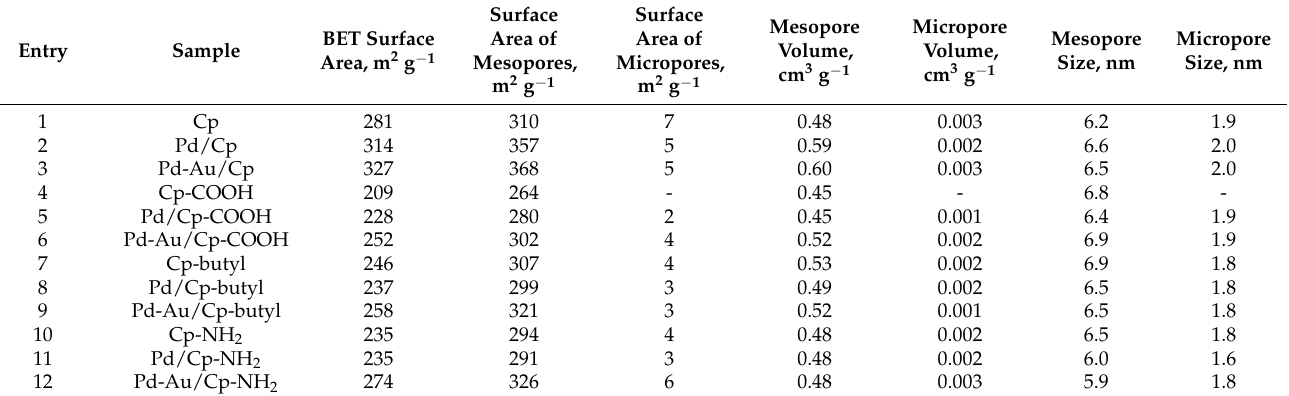
Figure 5. TEM images and EDX maps of the studied catalysts, as well as Pd and Pd-Au NPs distribution: ( a ) Pd/Cp; ( b ) Pd-Au/Cp; ( c ) Pd/Cp-COOH; ( d ) Pd-Au/Cp-COOH; ( e ) Pd/Cp-butyl; ( f ) Pd-Au/Cp-butyl; ( g ) Pd/Cp-NH 2 ; ( h ) Pd-Au/Cp-NH 2 . Table 3. Textural properties of supports and corresponding